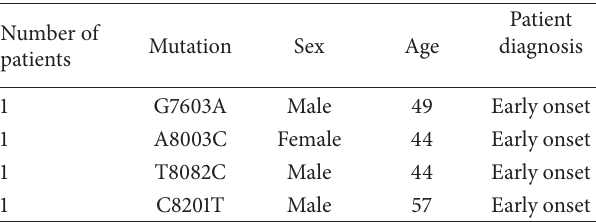
Table 3: Novel point mutations and patient’s characteristics. Number of